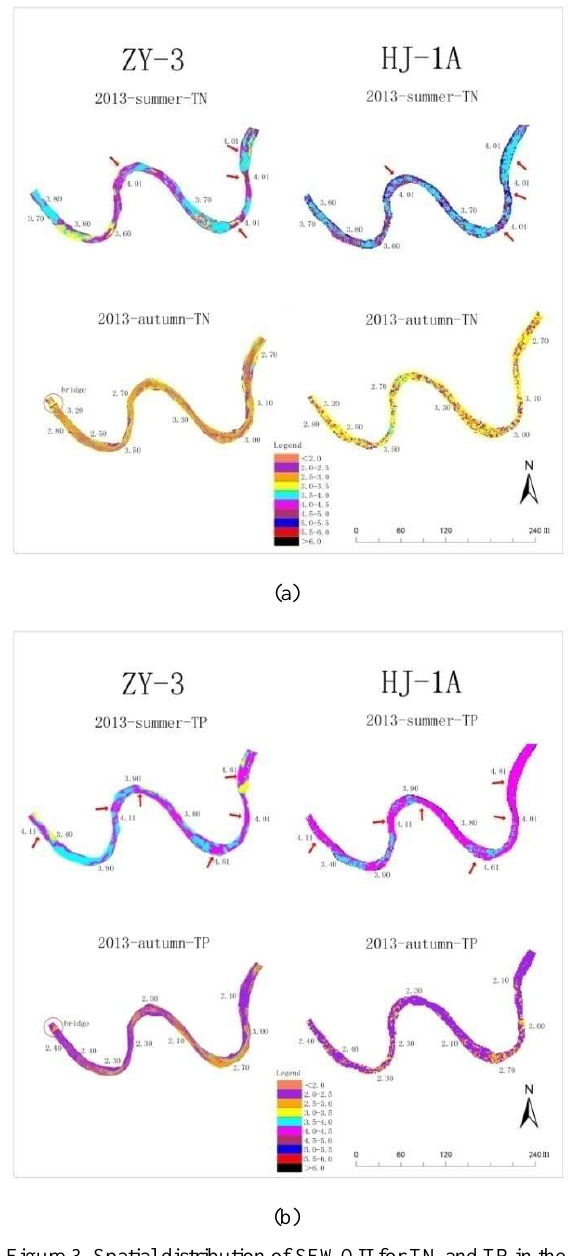
Figure 3. Spatial distribution of SFWQII for TN and TP in the study area,